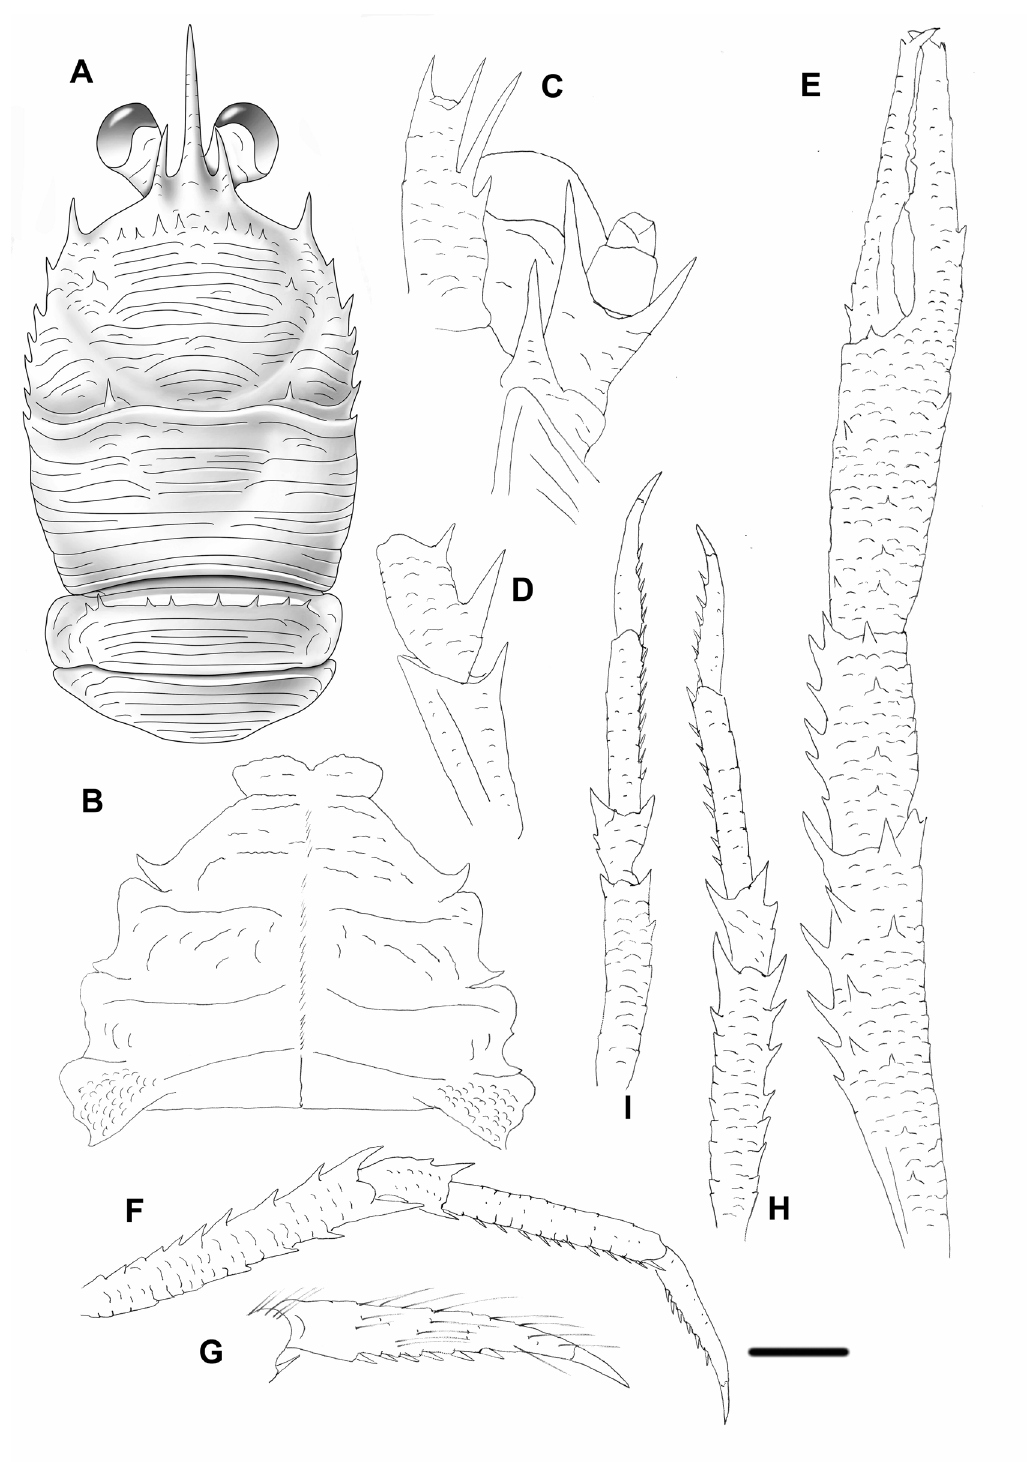
Fig. 4. Munida euripa sp. nov., holotype, ♂, 11.4 mm (MNHN-IU-2014-13475), Madagascar. A . Carapace and abdomen, dorsal view. B . Sternal plastron. C . Cephalic region, showing antennular and antennal peduncles, ventral view. D . Right Mxp3, lateral view. E . Right P1, dorsal view. F . Right P2, lateral view. G . Dactylus of right P2, lateral view. H . Left P3, lateral view. I . Right P4, lateral view. Scale bar: A, E–F, H–I = 3.0 mm; B–D, G = 1.5